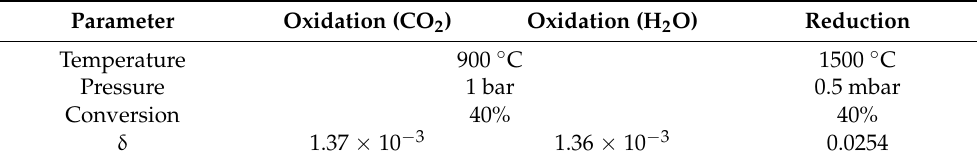
Table 1. Summary of conditions for reduction (R-102 and R-202) and oxidation reactors (R-101 and R-201). The conditions are identical for the oxidation with water and carbon dioxide, in exception of reaction extent ( δ ). It should be noted that δ refers to δ ox for the oxidation reactor and δ red for the reduction reactor. Parameter Oxidation (CO 2 ) Oxidation (H 2